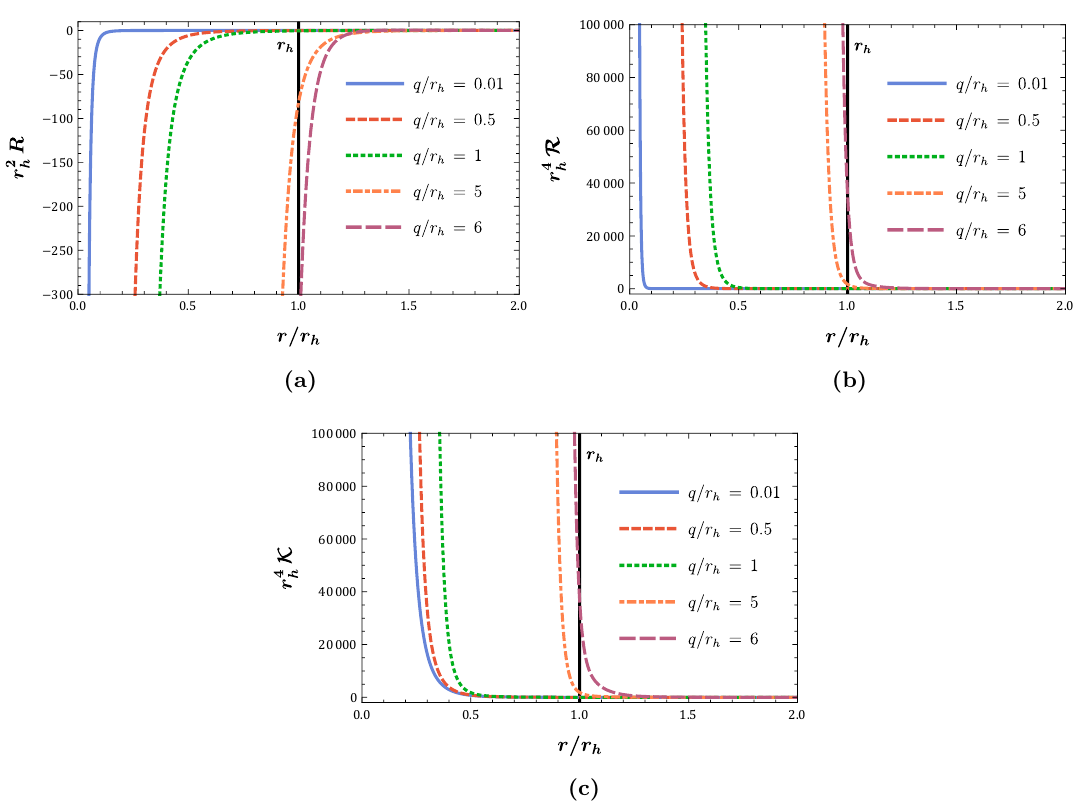
R , (b) the scalar r 4 R and (c) the Kretschmann scalar r 4 h h